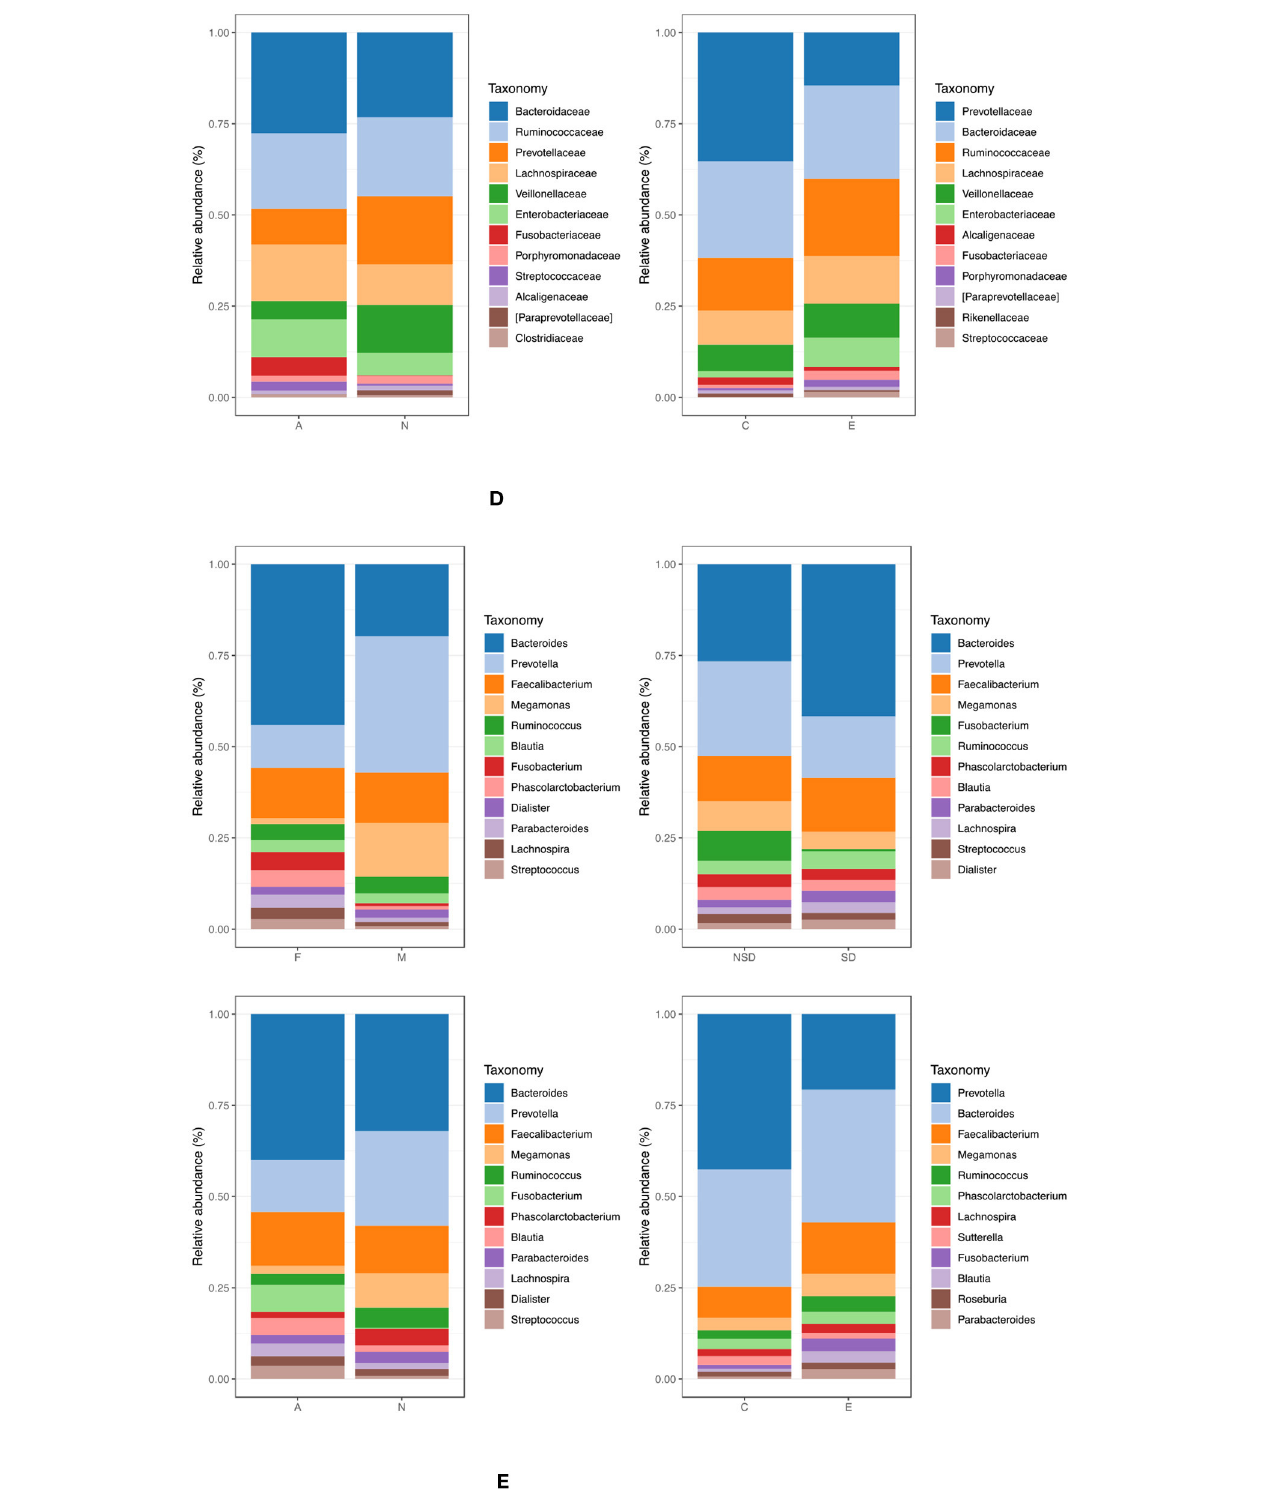
FIGURE 3 | Bar graphs show taxonomic summary comparing relative abundance of taxa species within samples at the level of phylum, class, order, family, genus, respectively. (Groups: F, females, M, males; NSD, non-sleep-disorder, SD, sleep-disorder; A, NERD patients with somatoform disorders, N, NERD patients without somatoform disorders; E, experimental group including all NERD patients, C, control group). (A) Phylum, most abundant, (B) Class, most abundant, (C) Order, most abundant, (D) Family, most abundant, (E) Genus, most abundant.